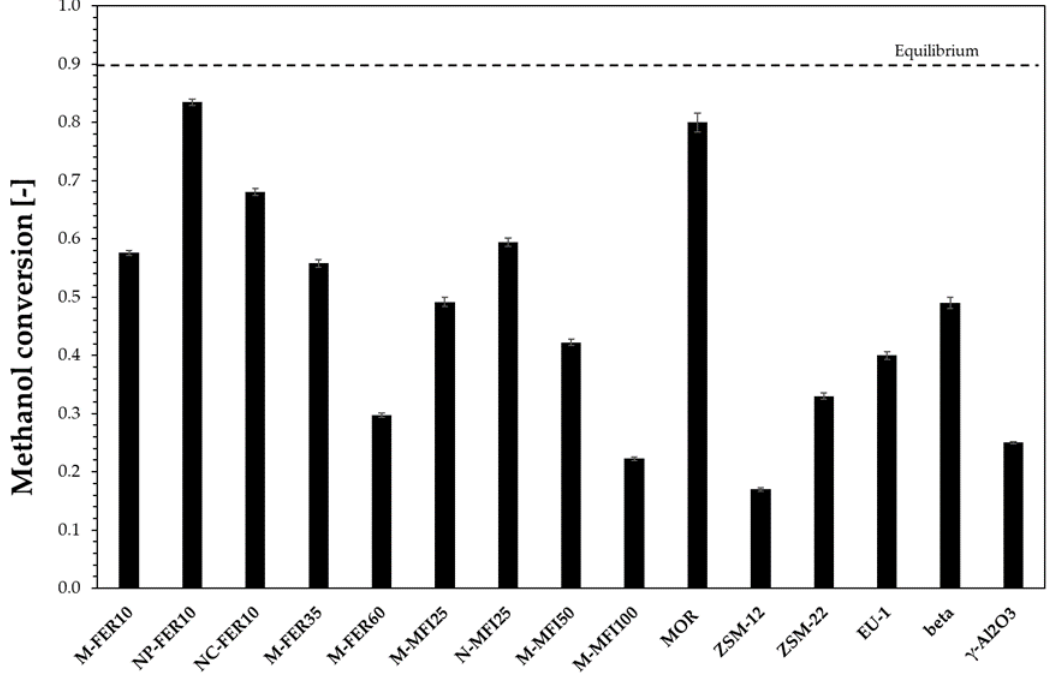
Figure 3. Methanol conversion at 200 °C. Dimethyl ether DME selectivity higher than 0.98 for all the samples.